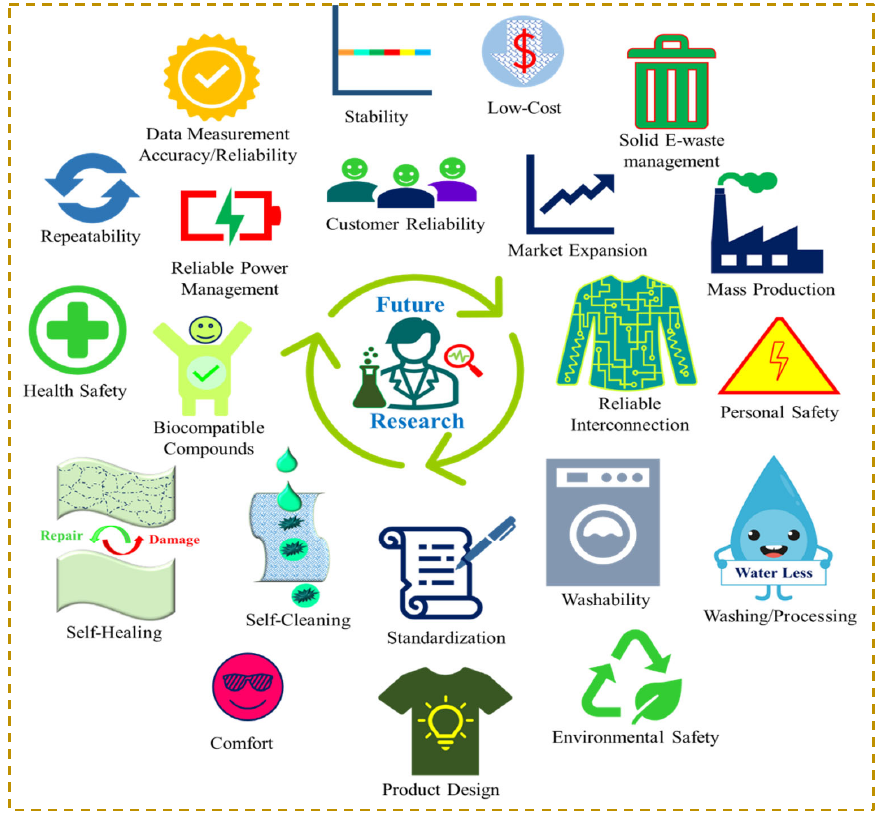
Figure 11. Futuristic highly robust and reliable e ‐ textiles for long ‐ term wearable electronic applica ‐ tions.